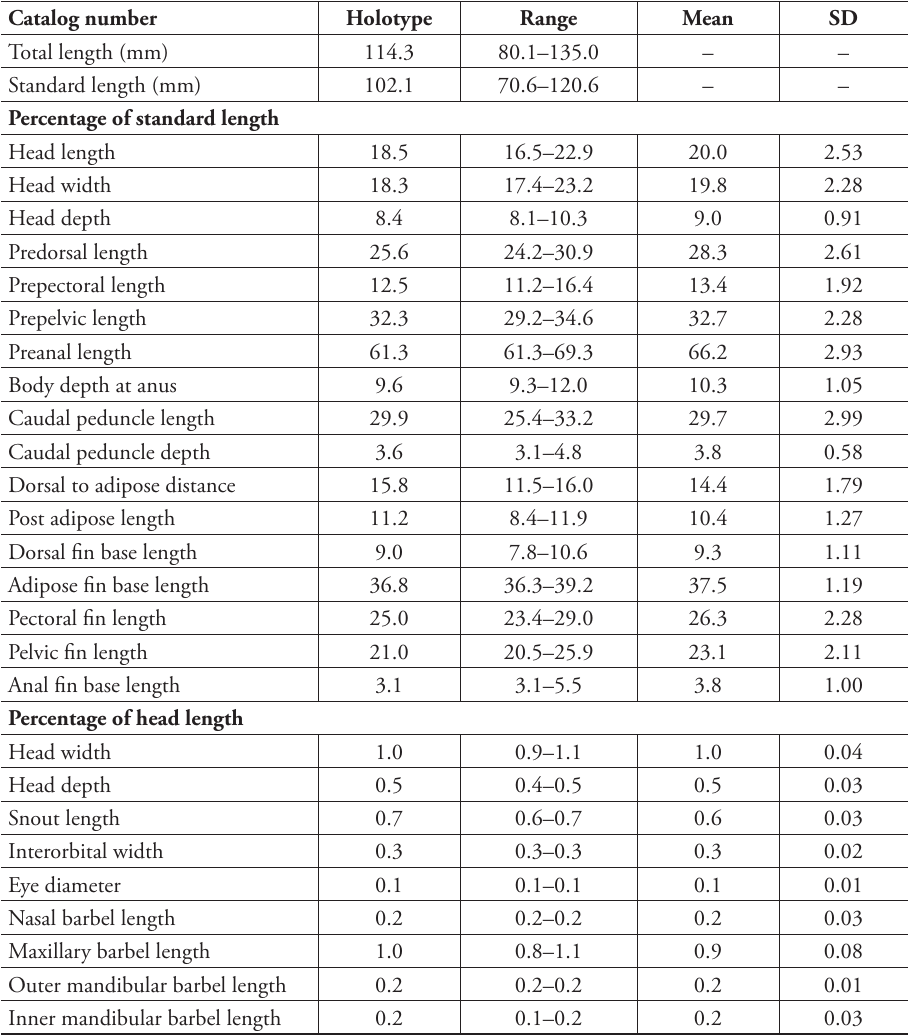
Table 1. Morphometric data of Oreoglanis hponkanensis sp. n. (n =